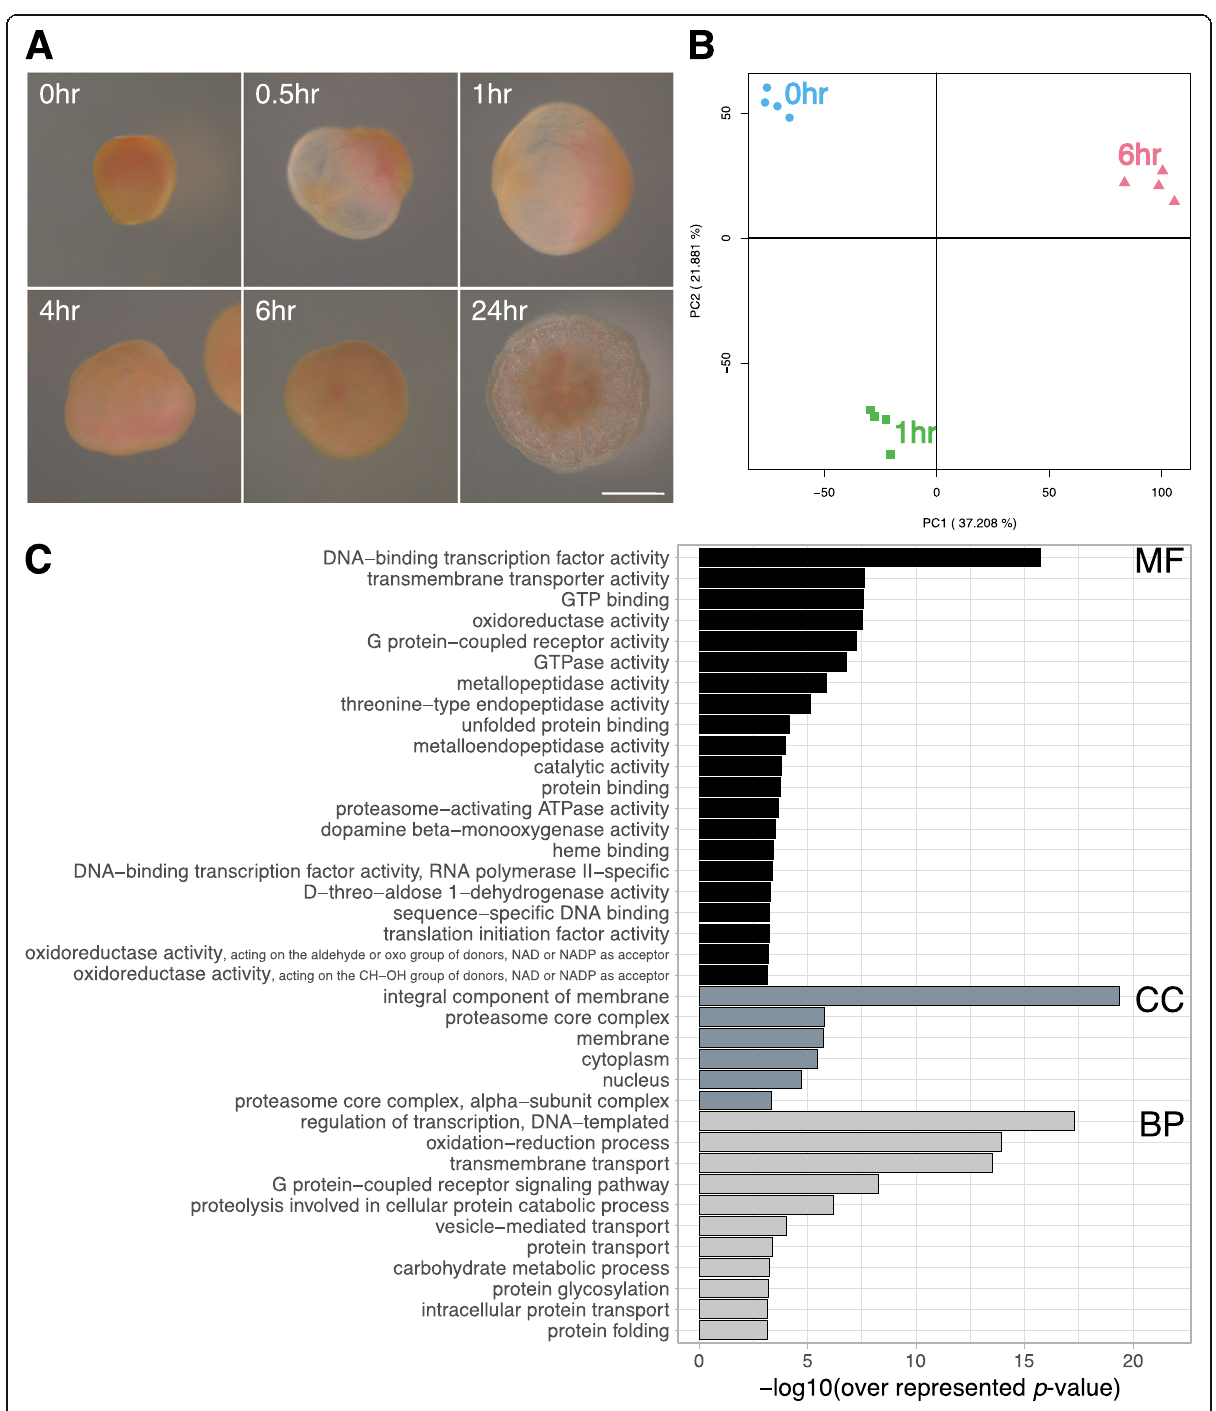
Fig. 1 Global pattern of gene expression in samples used for RNA-seq analysis. A Morphological changes in Acropora tenuis after the addition of Hym-248. The samples at 0 (i.e., before the addition of Hym-248) h, 1 h, and 6 h were subjected to RNA-seq analysis. Scale bar = 100 μ m. B PCA of gene expression patterns of each RNA-seq sample. C GO enrichment analysis of DEGs based on three categories: biological process (BP), cellular component (CC), and molecular function